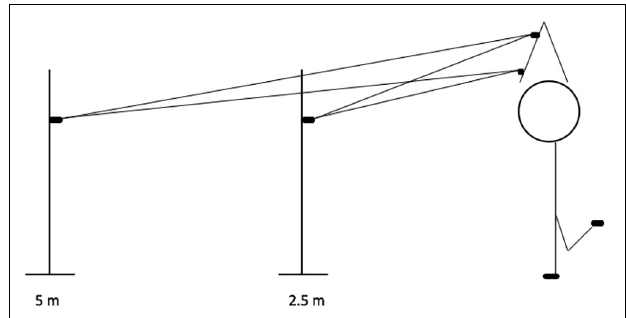
FIGURE 5 | Schematic representation of the task in Experiment